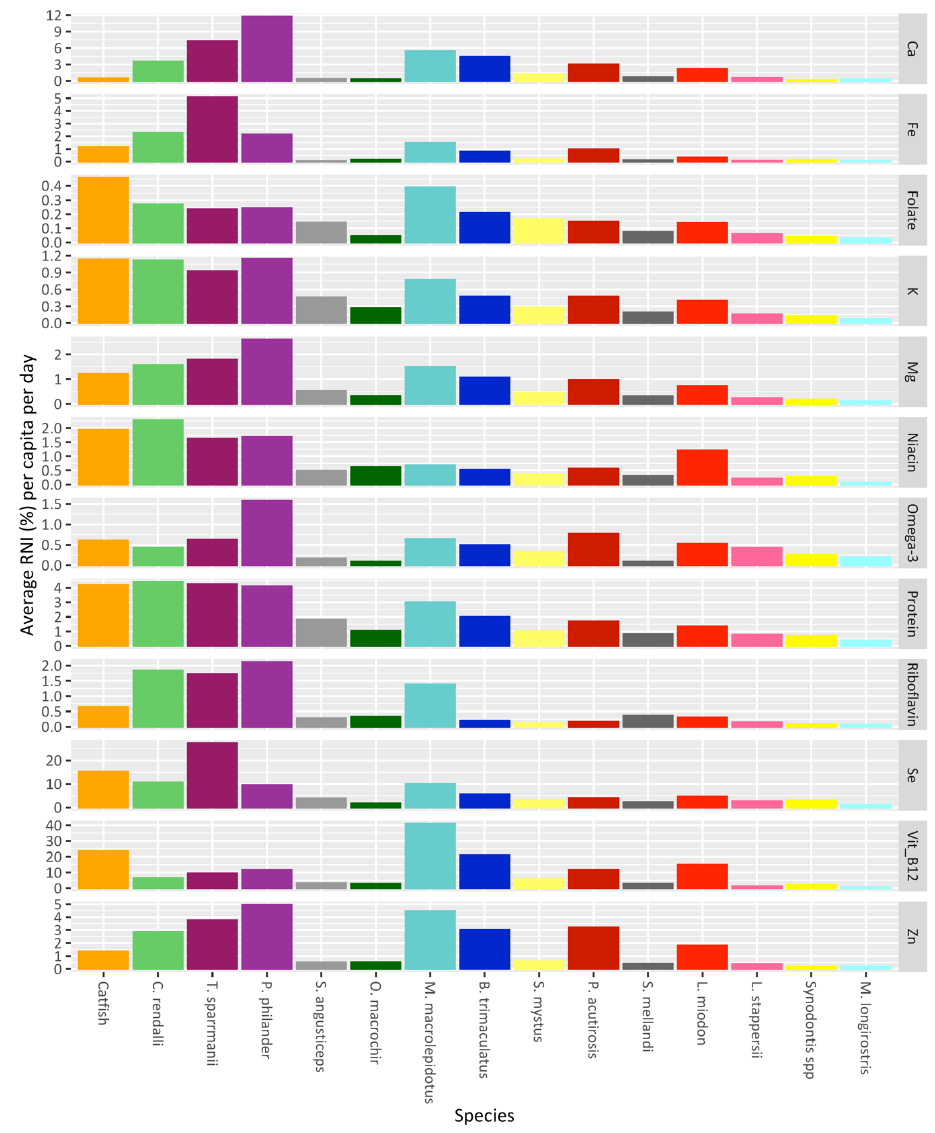
Figure 5. Average consumption of each nutrient per species as a percentage of the recommended nutrient intake (RNI) achieved for each nutrient per capita per day. From left to right, the species are ordered as the most to least consumed fish for the whole sample of households over the entire study period, in terms of the total weight (kg) of fish (i.e., not the wet weight equivalent).